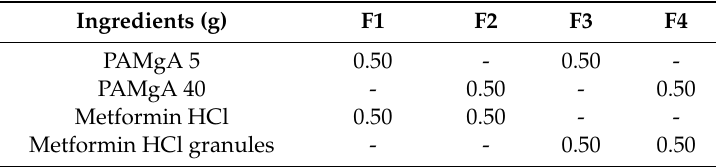
Table 2. Composition of metformin tablets F1–F4.